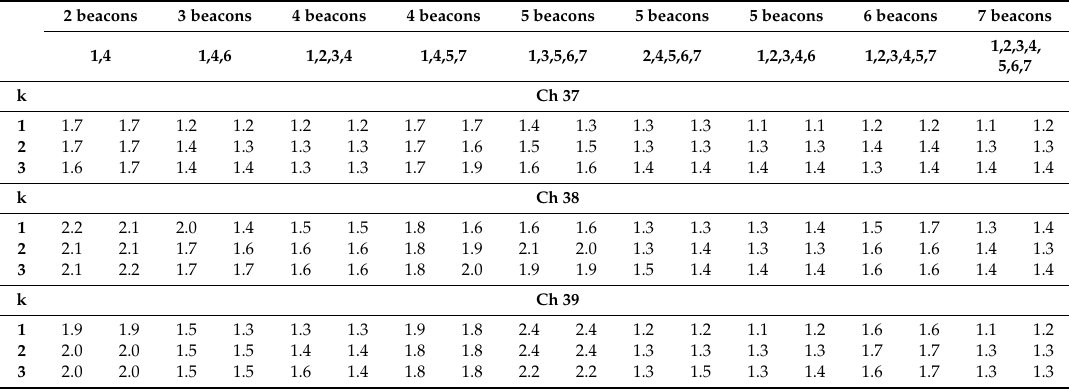
Table 16. Accuracies (in m) for Test #5, Tx code 7. For each beacon combination, the first and second data columns refer to the iBeacon and Eddystone protocol respectively. The first row shows the total number of beacons and the second shows the labels of the beacons used (see Figure 7b). The three advertising channels are referred to as Ch 37, etc., and the number of neighbors in the WKNN algorithm, as k